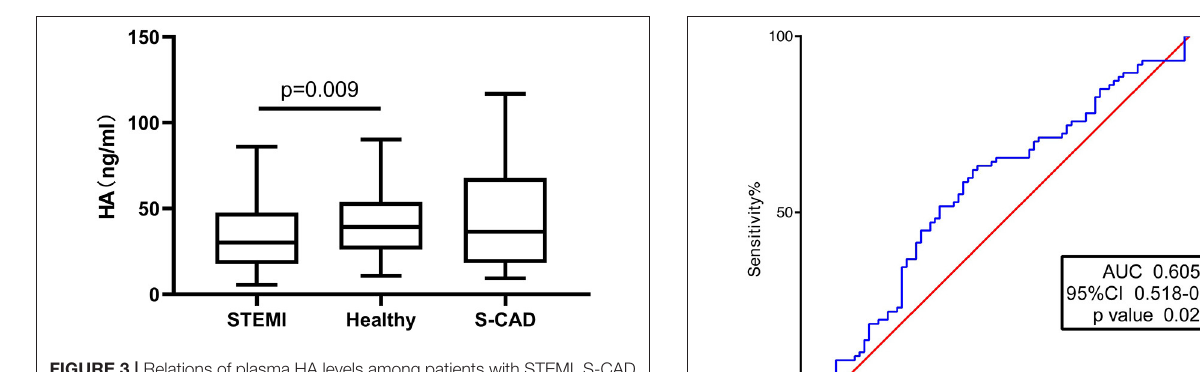
FIGURE 3 | Relations of plasma HA levels among patients with STEMI, S-CAD and healthy subjects. HA, hyaluronan; STEMI, ST-Segment–Elevation Myocardial Infarction; S-CAD, Stable Coronary Artery Disease.